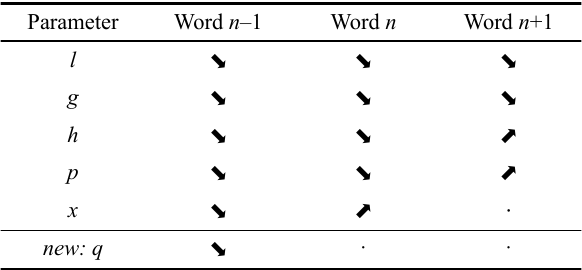
Table 4 Main Effects of Lexical Parameters on Gaze Durations Parameter